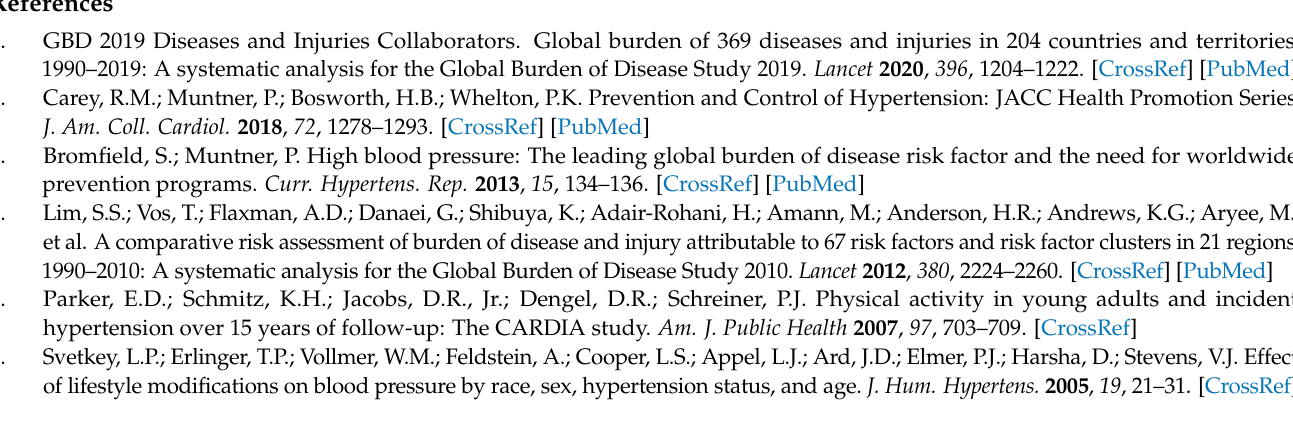
Table S2: Estimated mean differences in BP associated with a 1-point higher lifestyle scores and their components in a sample of the Airwave Health Monitoring Study ( n = 40,462) stratified by age; Table S3: Estimated mean differences in BP associated with a 1-point higher lifestyle scores in sub-cohorts of the Airwave health monitoring